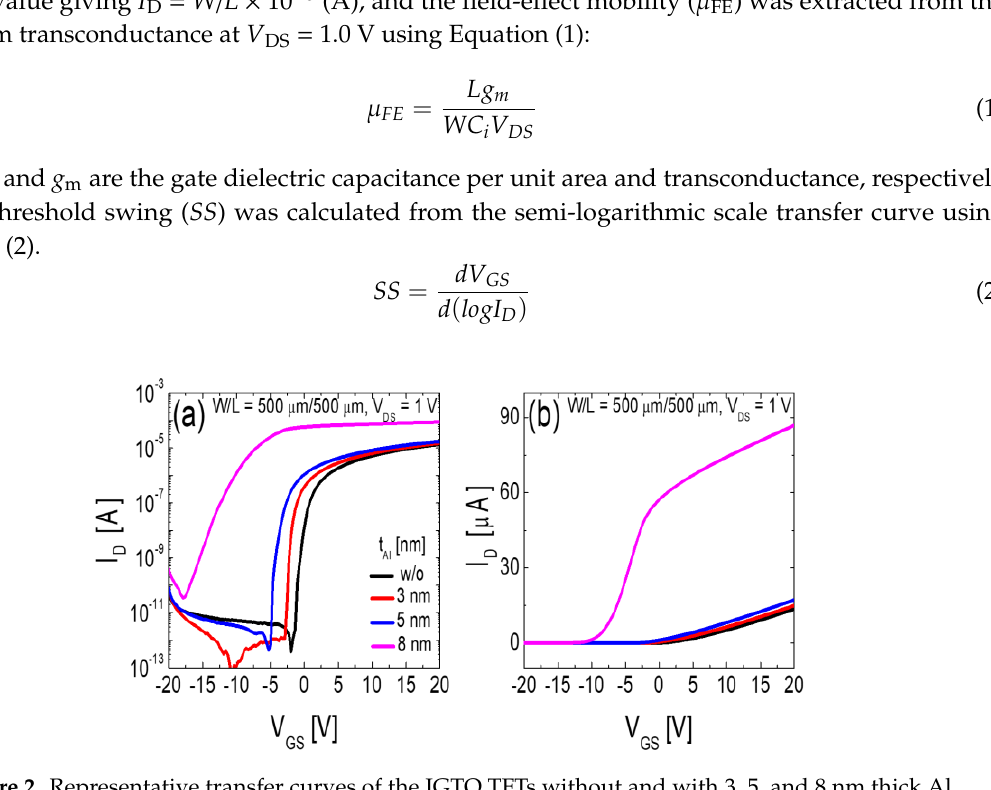
Figure 2. Representative transfer curves of the IGTO TFTs without and with 3, 5, and 8 nm thick Al capping layers on a ( a ) semi-logarithmic and ( b ) linear scale. Electrical characterization was conducted by sweeping V GS from −20 to 20 V at V DS = 1.0 V. Table 1. Electrical parameters extracted from the indium–gallium–tin oxide (IGTO) thin-film transistors (TFTs) without and with 3, 5, and 8 nm thick Al capping layers.